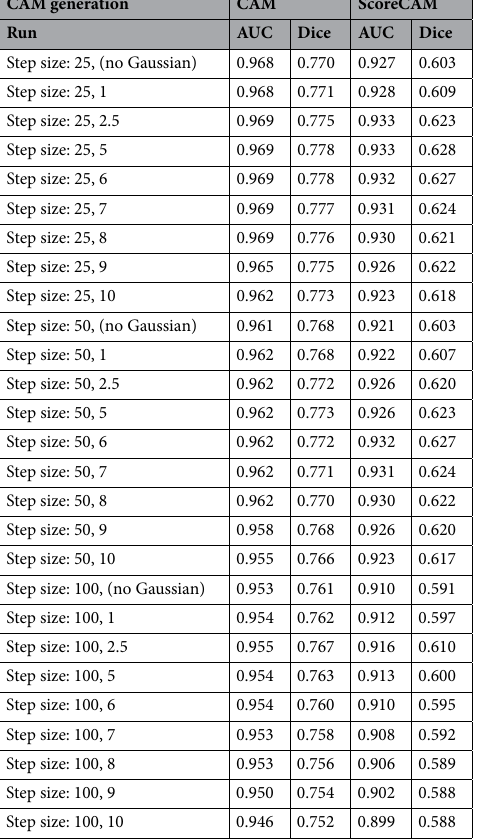
Table 2. The AUC and Dice scores calculated for each run as a function of step size and the width of the Gaussian weighting. Step size is given in pixels.